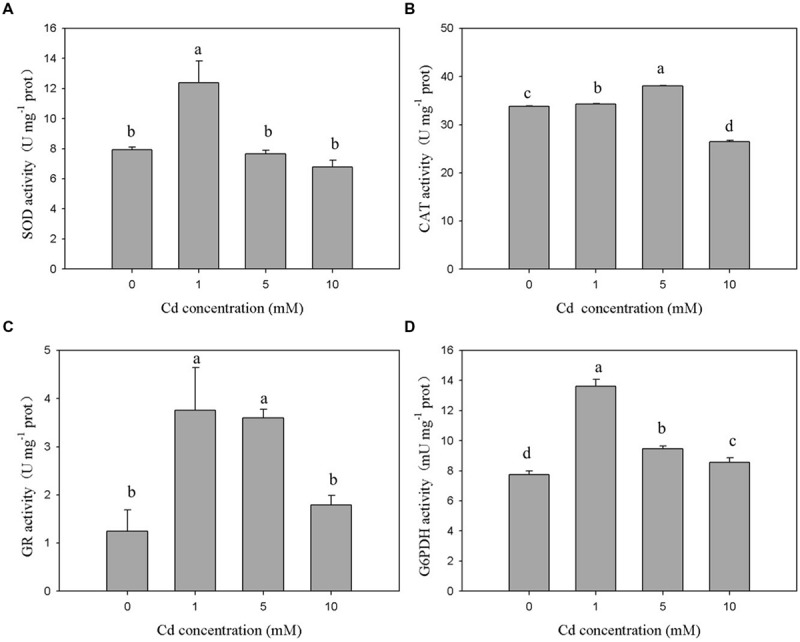
Effects of various Cd concentrations on the activities of antioxidant enzymes in P. chrysogenum XJ-1 exposed to Cd for 120 h. (A) SOD, (B) CAT, (C) GR, and (D) G6PDH. Bars with the same letter(s) are not significantly different at p > 0.05. (SOD, superoxide dismutase; CAT, catalase; GR, glutathione reductase; G6PDH, glucose-6-phosphate dehydrogenase; prot is indicative of protein).